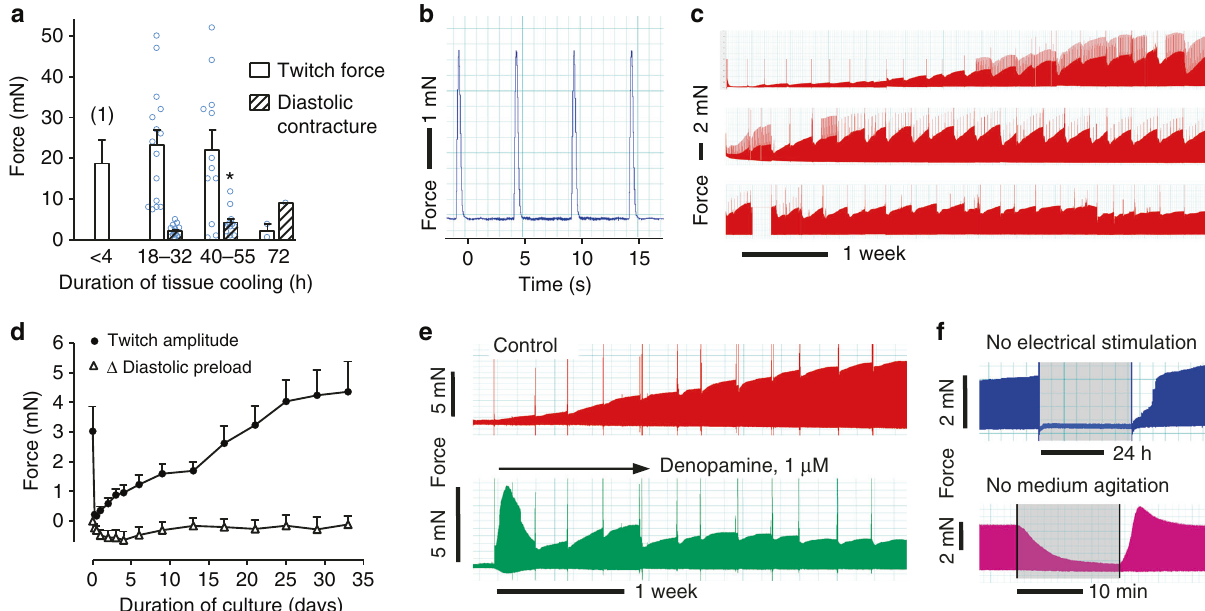
Fig. 2 Force development of cardiac slices before and during biomimetic culture. a Maximum twitch force and diastolic contracture of cardiac slices prepared after various durations of hypothermic tissue storage. Measurements were taken under isometric conditions in an organ bath. Data